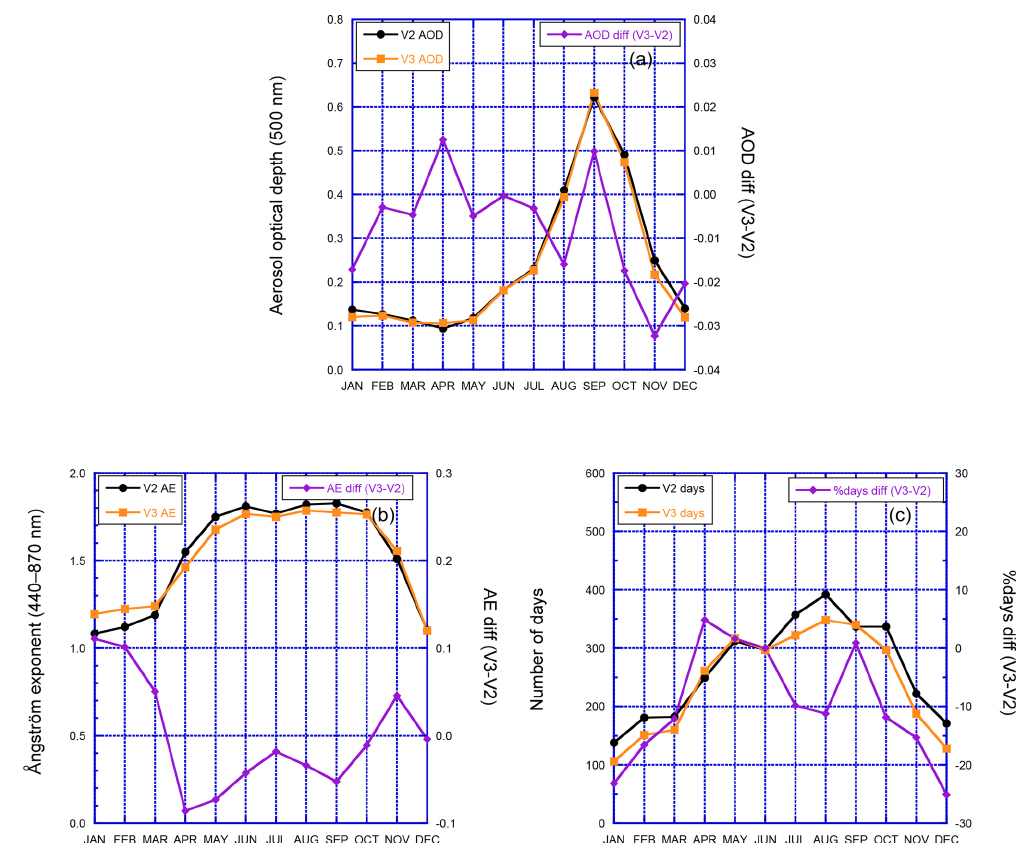
Figure 26. Similar to Fig. 23 except for Mongu, Zambia (lat − 15.25, long 23.15), from 1997 to 2010.